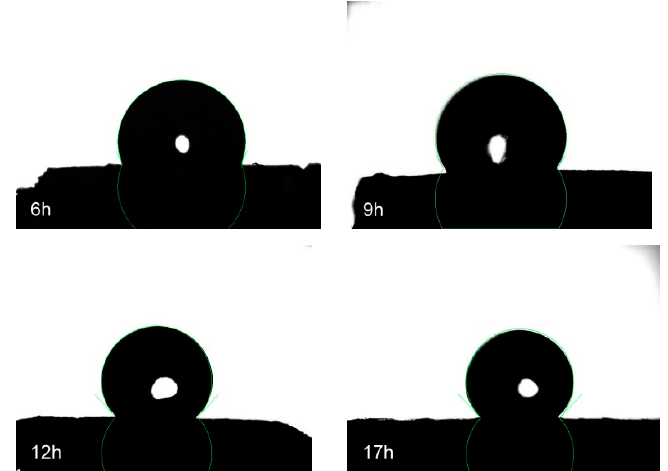
Figure 8. Measurements of water contact angle of cellulose aerogels after different coating processes.